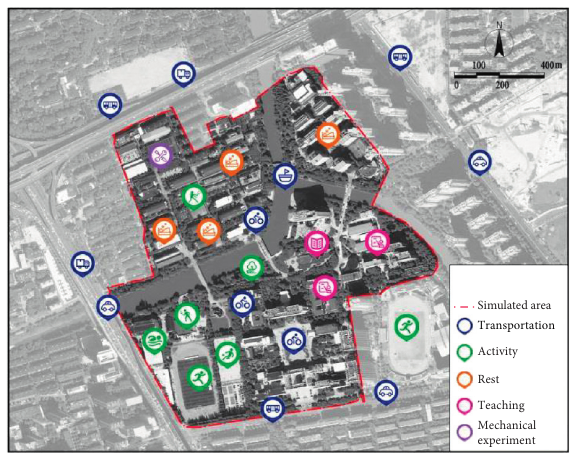
Figure 2: Diagram of functional zone and sound identifiers.